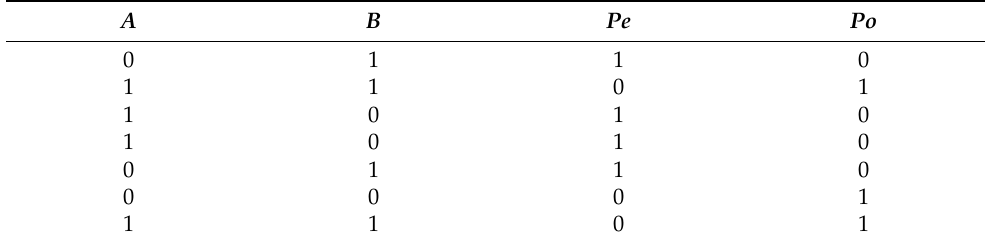
Table 1. Truth table of parity